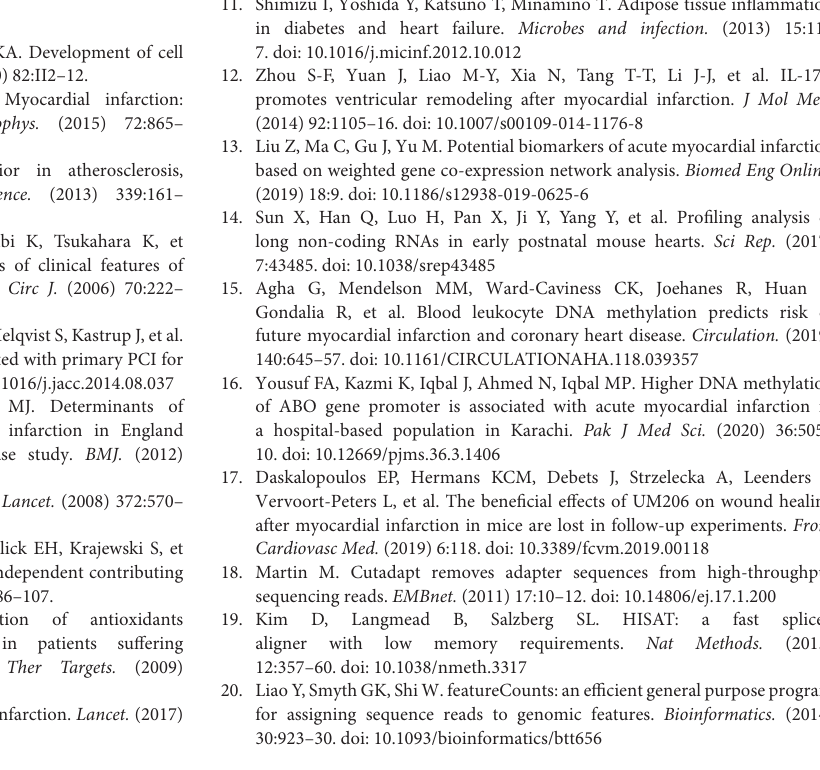
Supplementary Figure 1 | Bar chart of the number of up-regulated and down-regulated differential genes at different time points. Supplementary Figure 2 | Rainfall plots for differentially methylated regions (DMR) and their genomic densities. In the plot, red corresponds to hypermethylated DMRs (gain of methylation) and blue corresponds to hypomethylated DMRs (loss of methylation). (A–E) The rainfall plots of DMRs distribution at 10min, 1, 6, 24, and 72h after MI. Supplementary Figure 3 | Venn diagram of DEGs and DMGs. Each group was further divided into up-regulation group and down-regulation group. The number of genes is given in the middle of each figure section. (A–E) The venn diagram at 10min, 1, 6, 24, and 72h after MI. Supplementary Table 1 | The genes included in profile #3, profile #4 and profile #7 and their FPKM expression values at 0, 1, and 72h. Supplementary Table 2 | The genes localized in the promoter region at 10min, 1, 6, and 24h and with expression changes opposite to the methylation